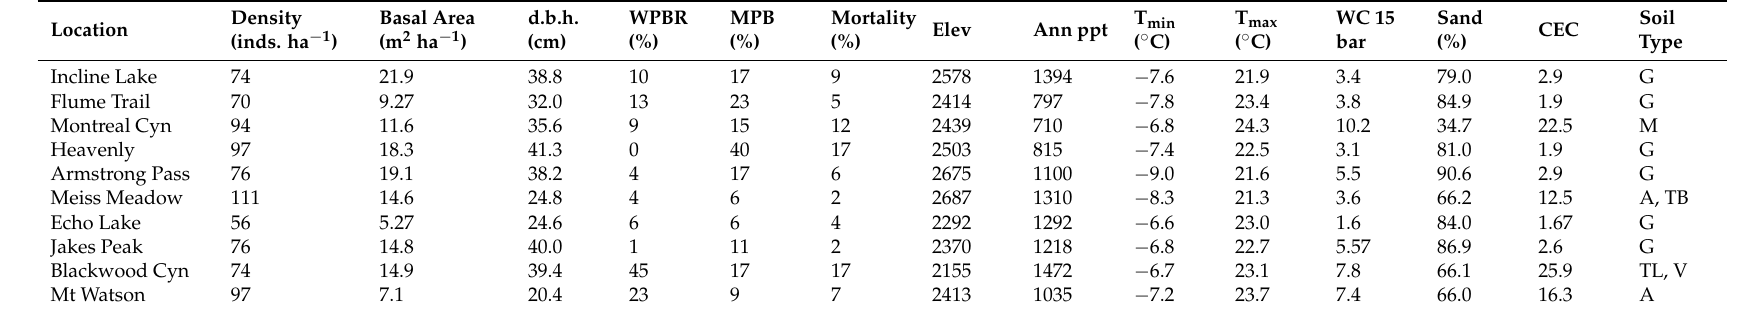
Table 1. Biological and environmental summaries for 10 populations of Pinus monticola in the Lake Tahoe Basin. Stands are listed clockwise in orientation in the Lake Tahoe Basin from north, east, south, and west. d.b.h. (cm) (diameter at breast height); % WPBR (white pine blister rust) = % incidence of WPBR; % MPB (mountain pine beetle) = % incidence of MPB; Elev. = elevation above sea level/a.s.l. (m); Ann. ppt. = total annual precipitation in millimeters (mm); T min ( ˝ C) = minimum January temperature; T max ( ˝ C) = maximum July temperature; WC 15 bar = soil water capacity at 15 bar; % sand = percentage sand content (sand:silt:clay); CEC = cation exchange capacity. See Methods for sources of climate and soil survey